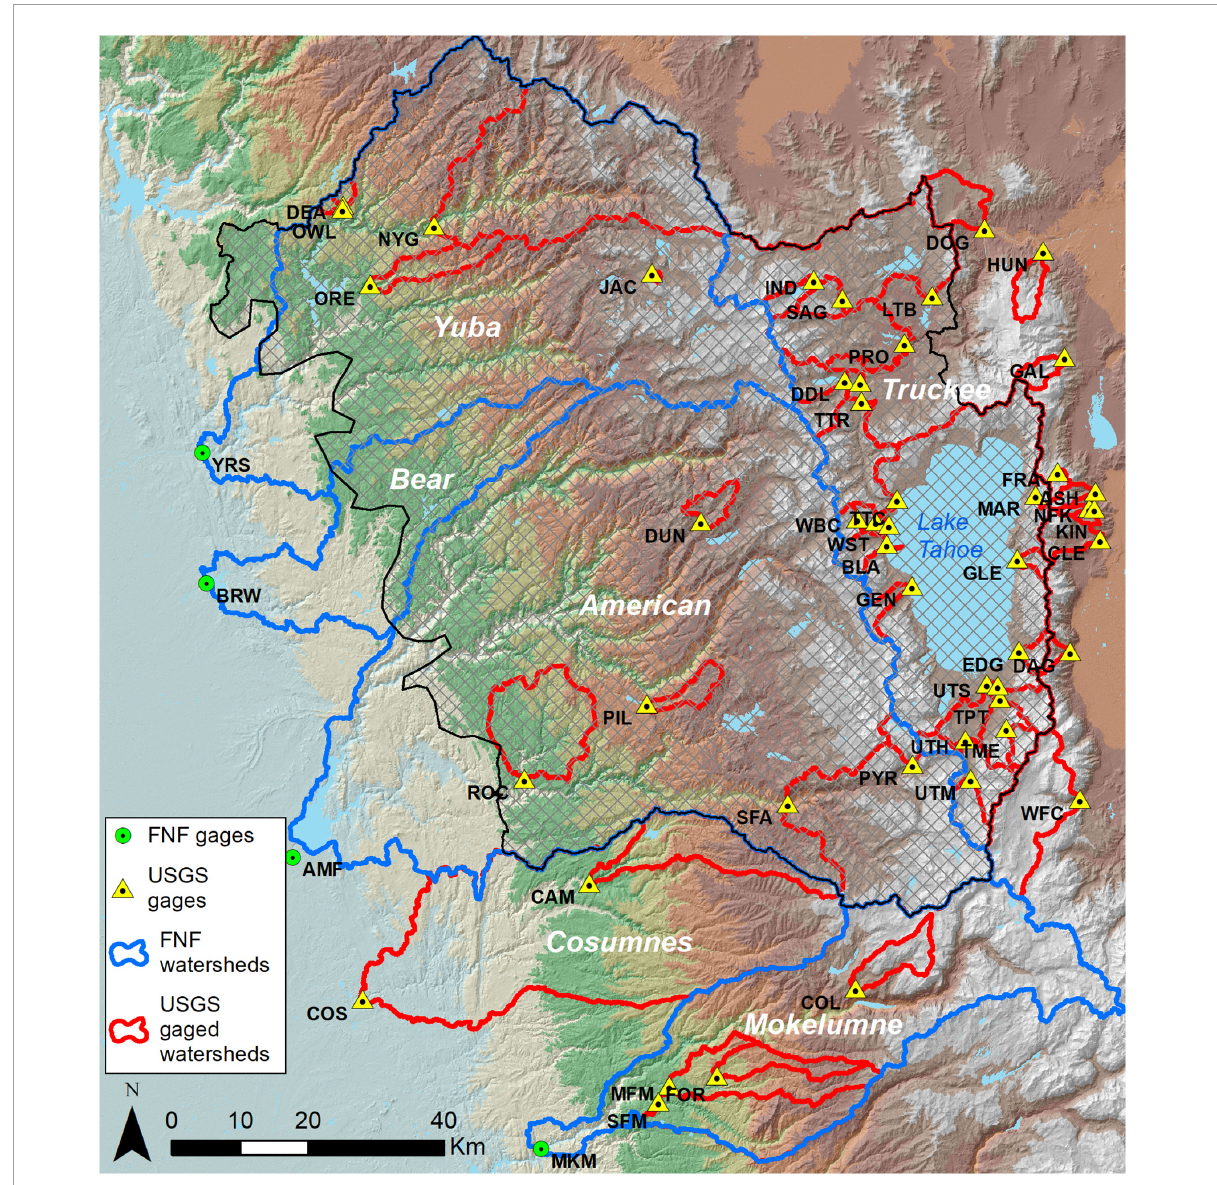
FIGURE1 Study area. Watersheds outlined in blue are those for which full natural flow (FNF) data existed. The Tahoe Central Sierra Initiative project area is cross-hatched with a black outline. USGS and full natural flow gauge names, abbreviations, and locations are listed in Table 1 and Supplementary Table S1